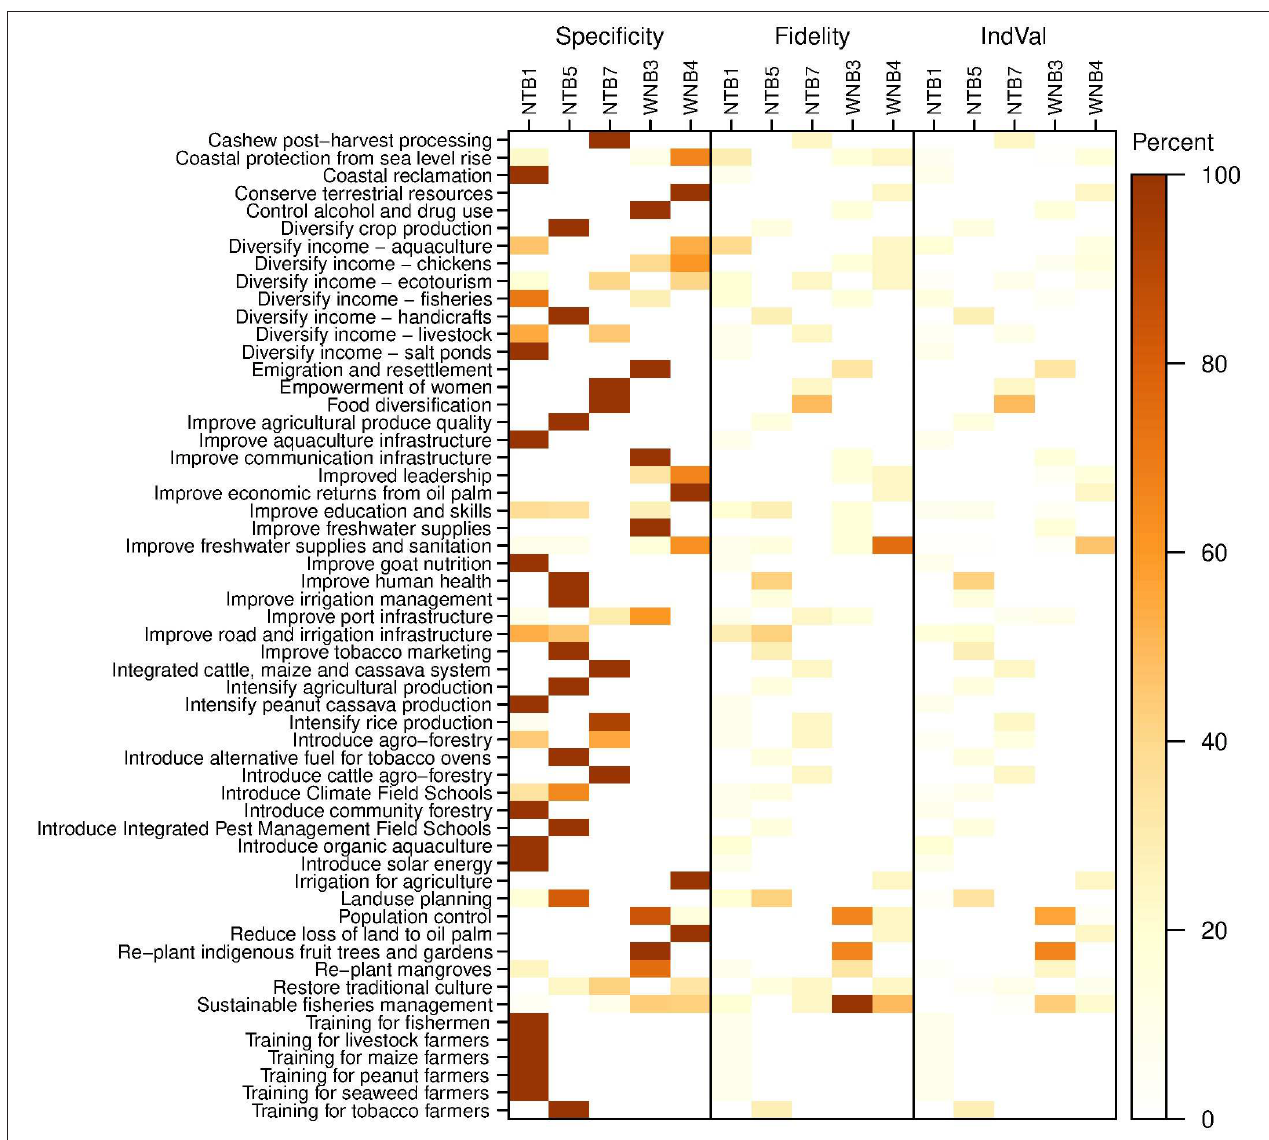
FIGURE 7 | Values of strategies within sub-district types. Specificity indicates whether a strategy is concentrated in a particular type, fidelity is the frequency of the strategy in each type, and IndVal combines the